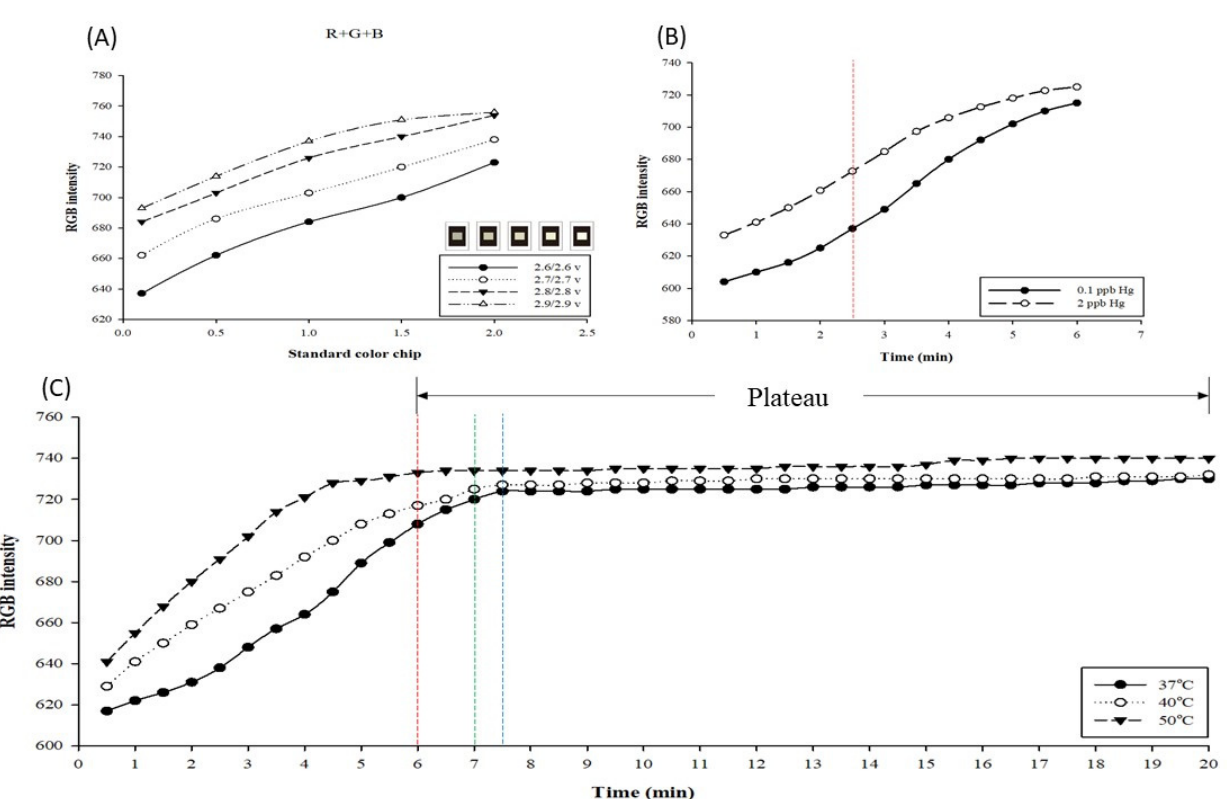
Figure 2. Optimal testing parameters for mercury detection using the paper-based chip combined with AgNPs. ( A ) Determining the three best primary color resolutions of standard color films under different light source intensities, R, G, B, and R+G+B. ( B ) Curve of mercury detection with AgNPs at 37 °C, 40 °C, and 50 °C for 0.5–20 min. ( C ) The curve of the 0.1 and 2 ppb mercury standards for silver nanoparticle detection in 0.5–6 min.